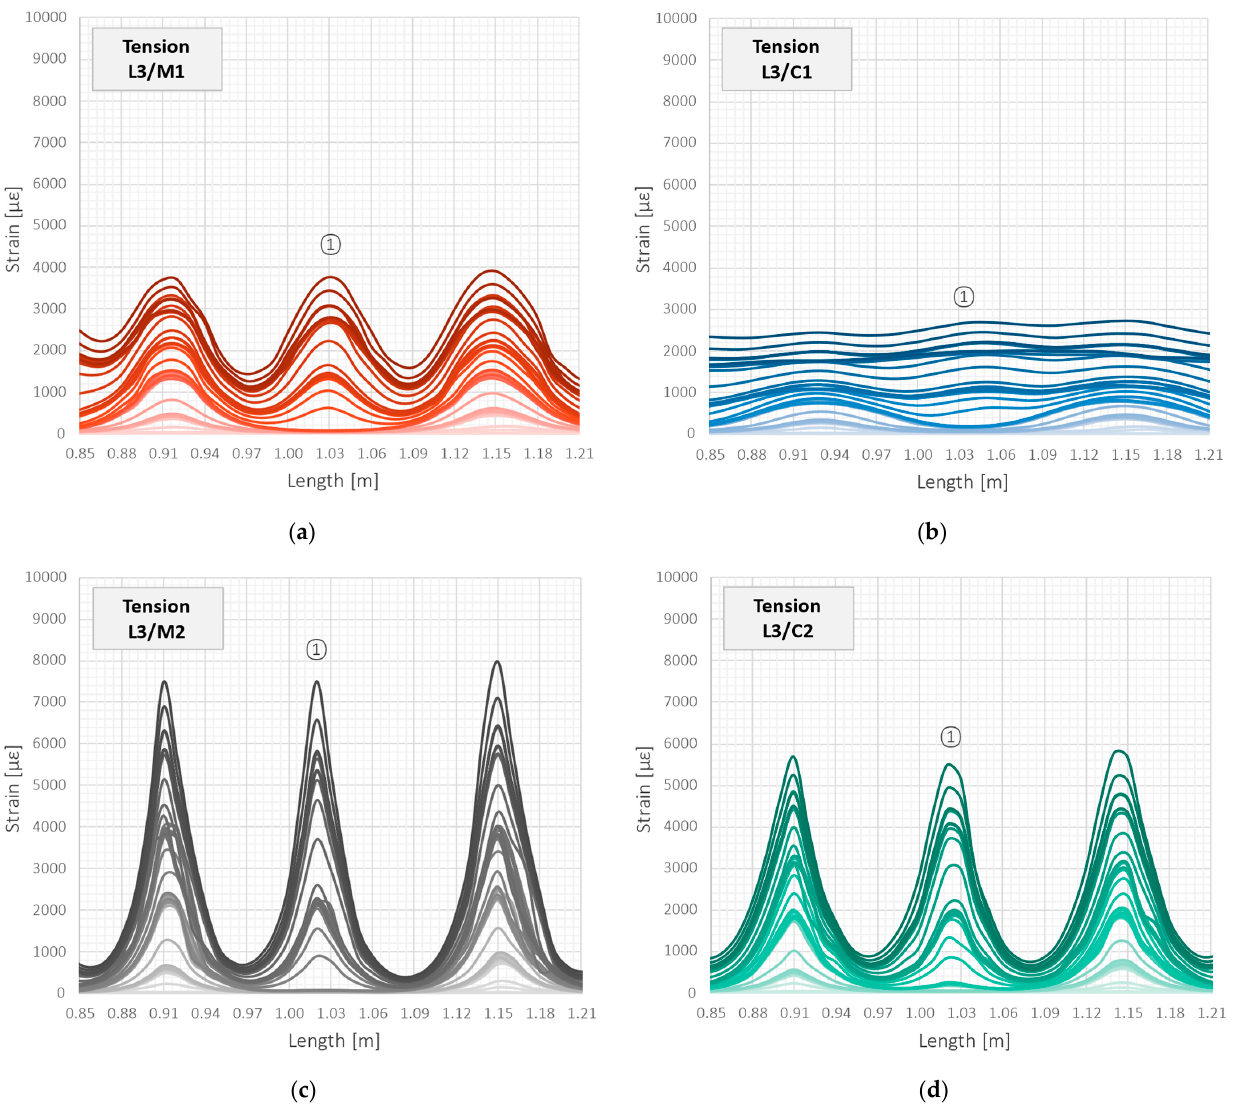
Figure 22. Beam L3/tension zone: strain profiles in close vicinity of crack no. 1 registered by the following DFOS tools: ( a ) M1; ( b ) C1; ( c ) M2; ( d ) C2.